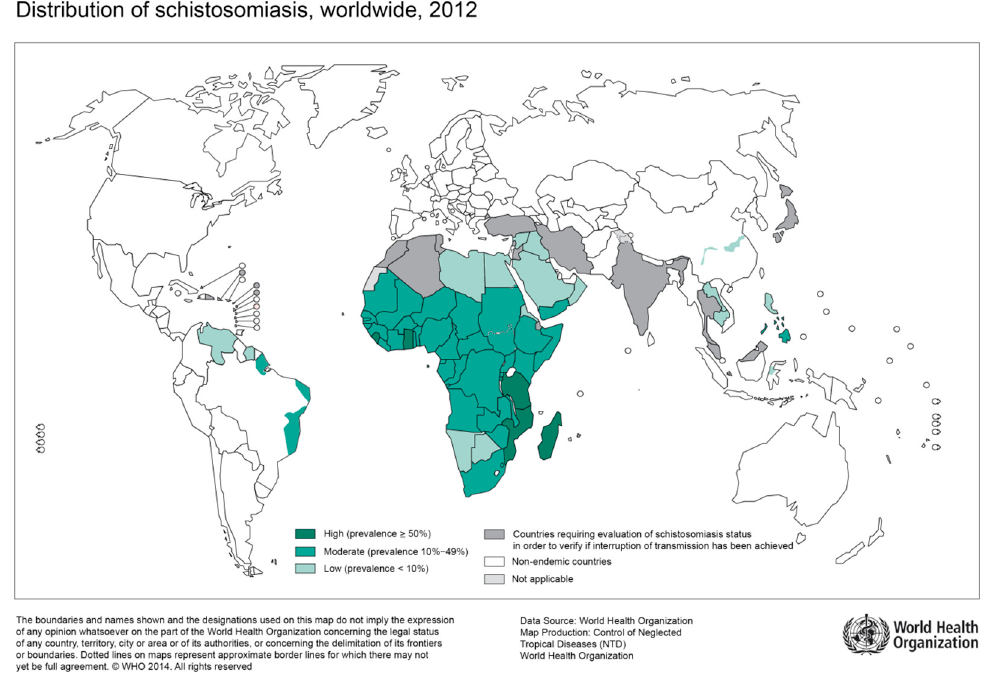
Figure 1. Global distribution of countries where human schistosomiasis is transmitted [9]. (Source: WHO, website: https://www.who.int/schistosomiasis/Schistosomiasis_2012-01.png?ua=1)